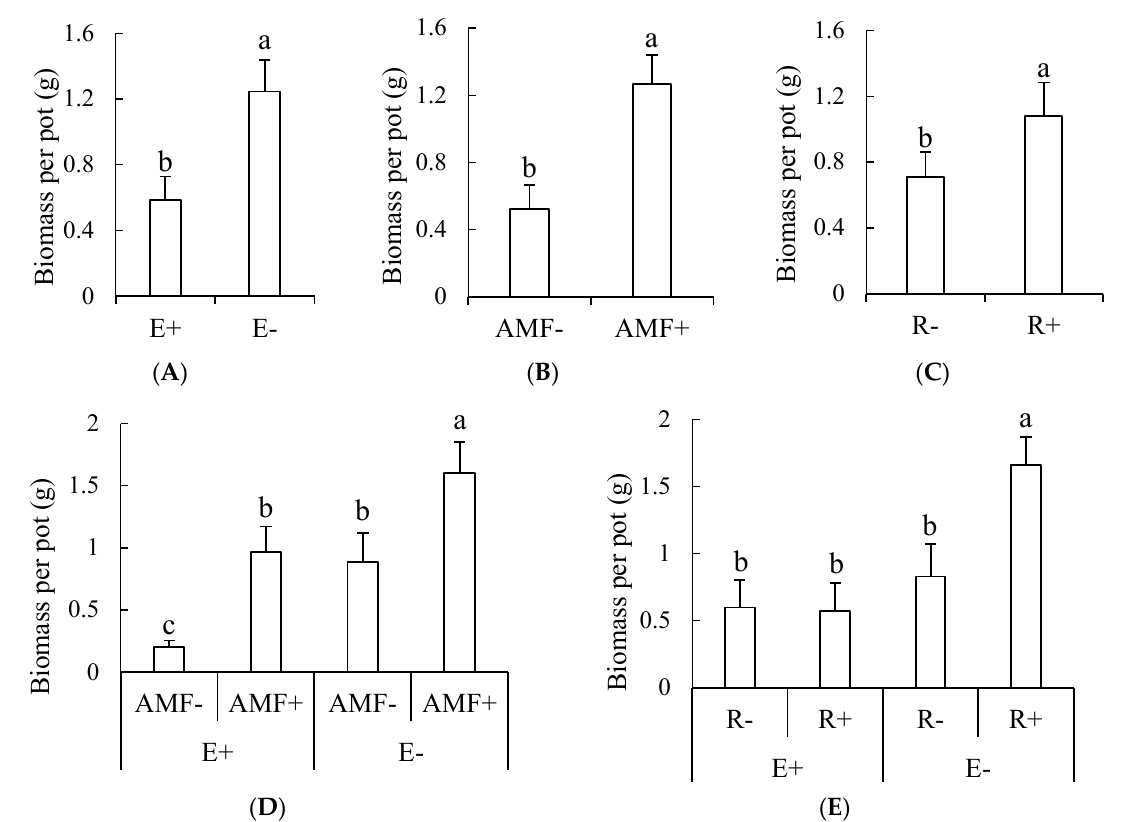
Figure 2. ( A – E ) The influence of endophytic fungi, AMF and rhizobia on the biomass of clover. E+, endophyte-infected tall fescue; E − , endophyte-free tall fescue; AMF+, AMF-inoculated; AMF − , AMF-free; R+, rhizobia-inoculated; R − , rhizobia- free. Different small letters indicate significant differences between treatments ( p < 0.05).